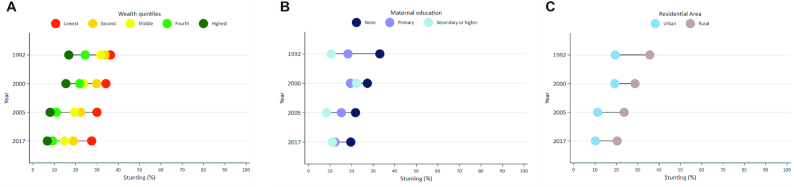
Stunting prevalence by wealth quintile, 1992/93–2017 (A). Stunting prevalence by maternal education, 1992/93–2017 (B). Stunting prevalence by residential area, 1992/93–2017 (C).